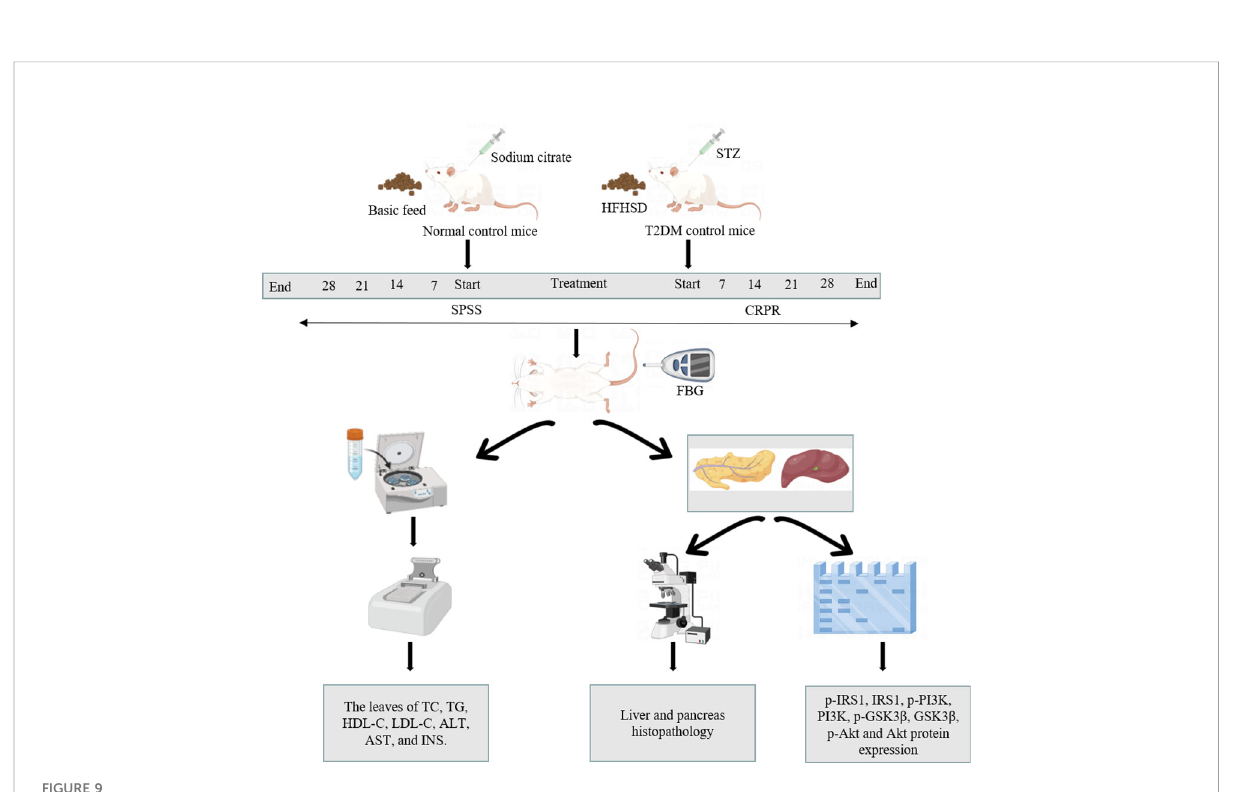
FIGURE 9 Work fl ow of animal study.